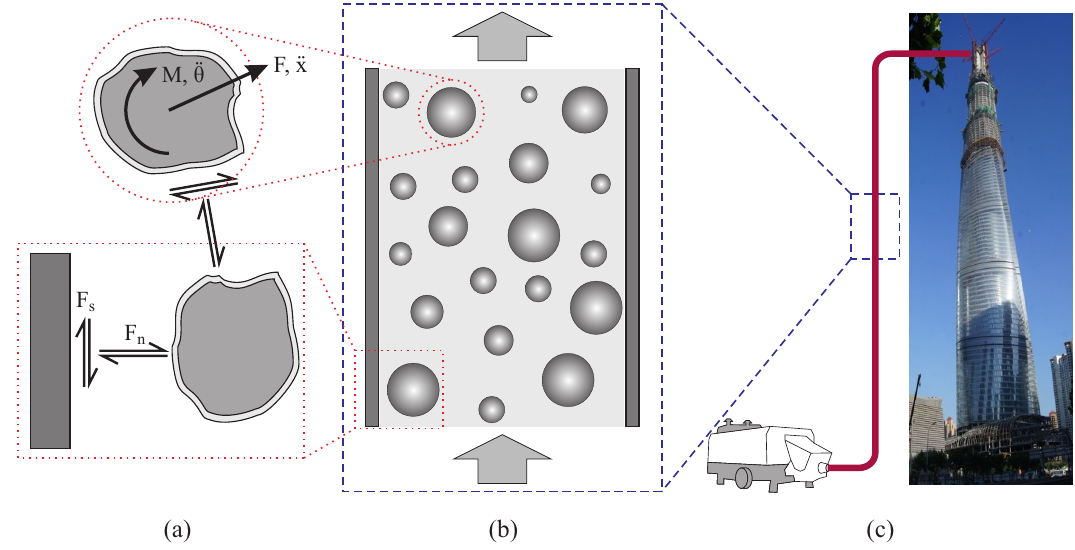
Figure 1. Concept for the concrete pumping analysis: ( a ) material behavior at the mesoscale; ( b ) local concrete flow in pipe; and ( c ) whole system during